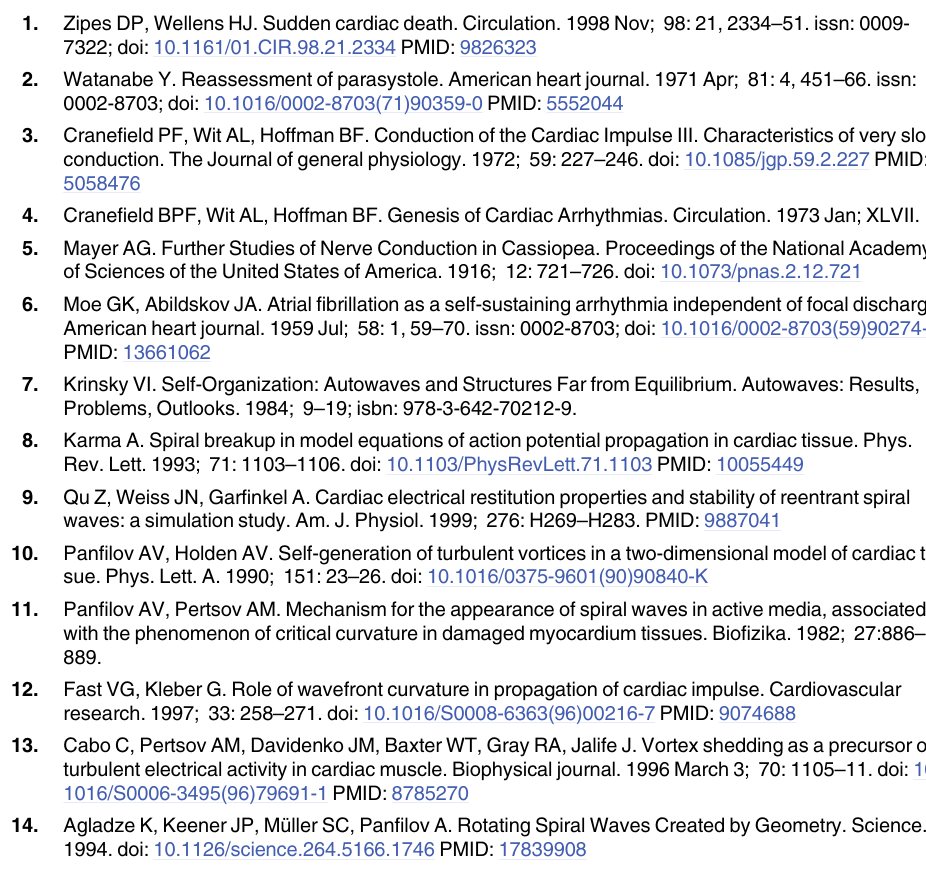
S2 Table. Critical AR for various conductivities of ionic currents and external [ K + ] centration. The table contains pairs of periods of stimulation ( T the critical period of stimulation. Wave propagation through the border is possible for all stim- ulation periods T (cid:5) T pass , and block occurs for every T (cid:6) T block . (List 1) contains dependencies of critical periods ( T pass , T block ) on AR with fixed conductivity or external [ K + ] o concentration; (List 2) contains dependencies of AR on [ K + ] o with fixed stimulation frequencies. These data were used in Figs 4 –